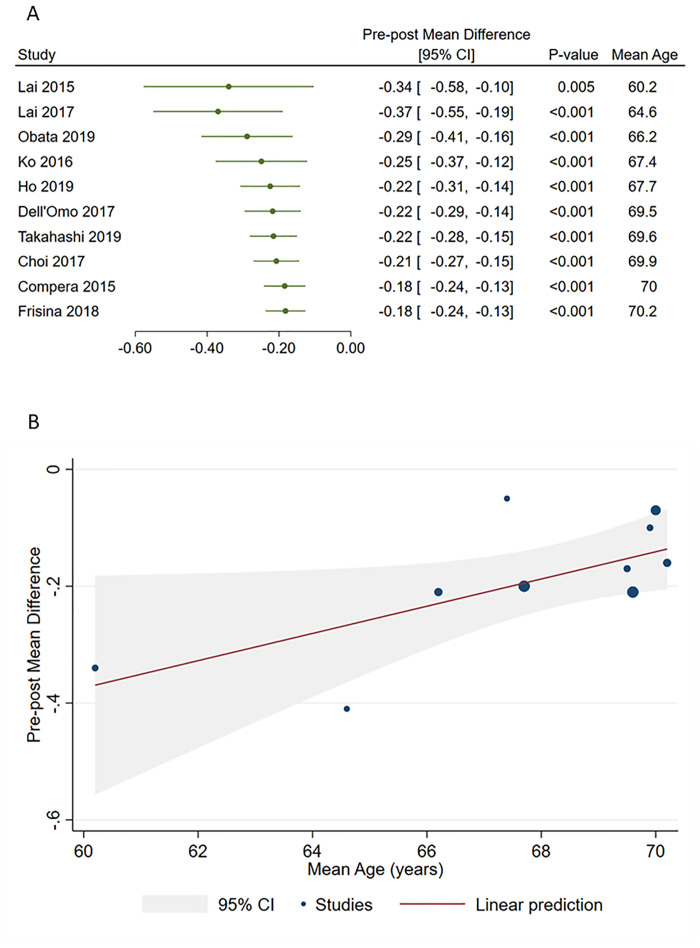
Cumulative meta-analysis (A) and meta-regression (B) showing relationship between patient age and pre-post mean difference in BCVA in the degenerative LMH and LHEP group.